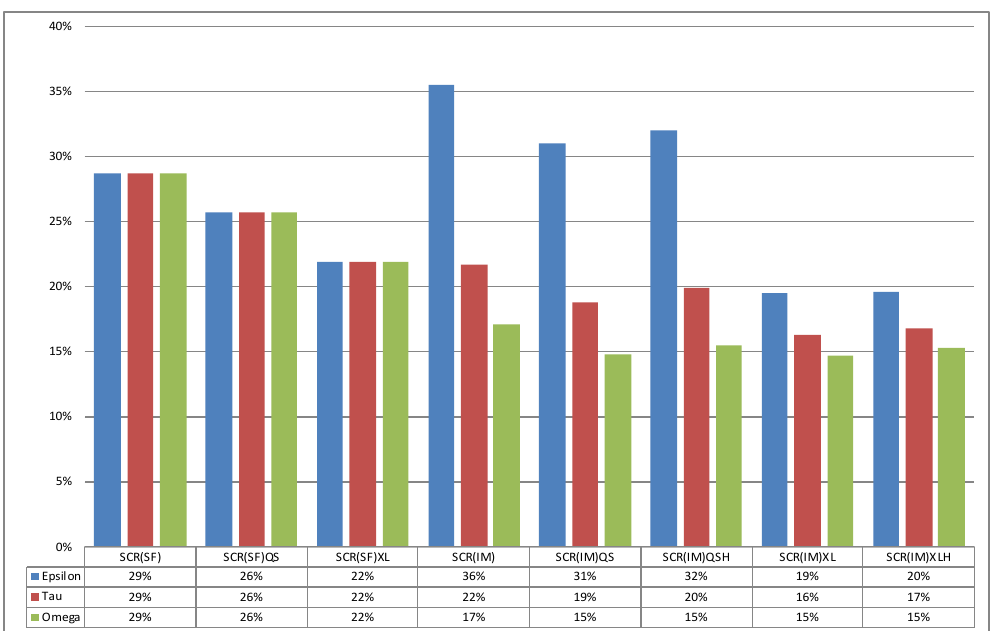
Figure 9. Liabilities portfolio mix: ratio